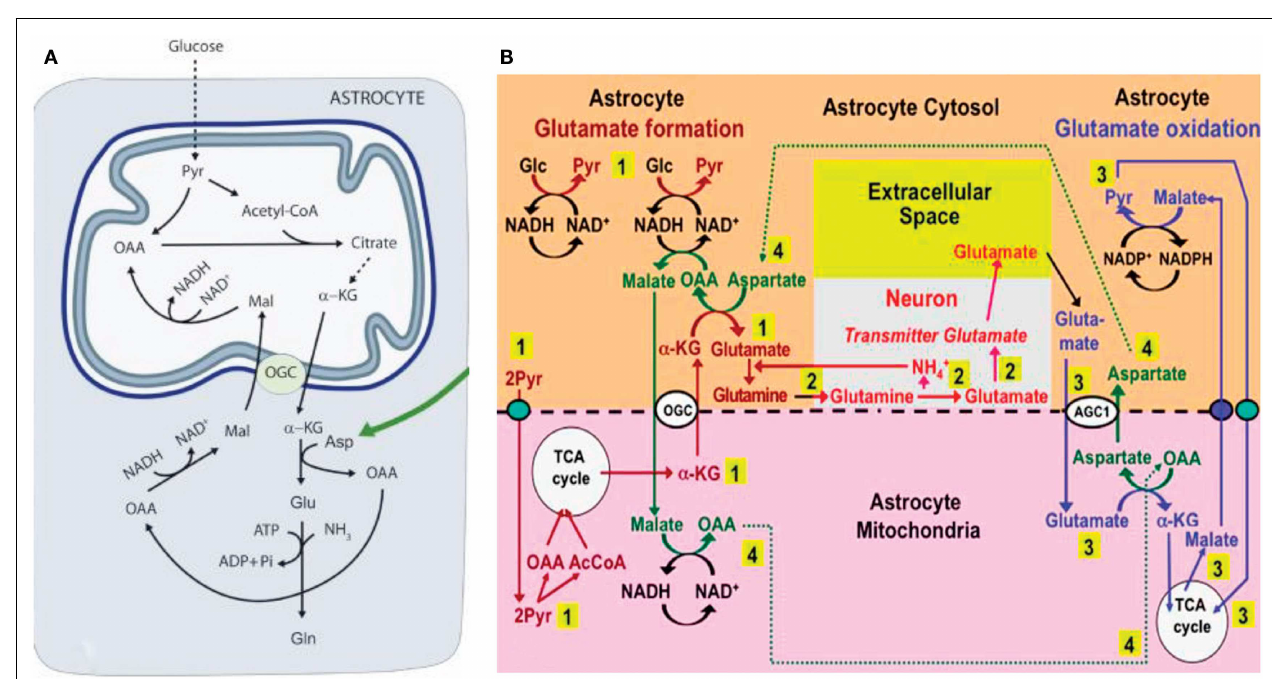
glutamate (pathway 2), and subsequent reuptake of glutamate and oxidative metabolism in astrocytes (pathway 3), with connections between pathways 1 and 3 shown as pathway 4. Biosynthesis of glutamine is shown in brown and metabolic degradation of glutamate in blue. Redox shuttling and astrocytic release of glutamine and uptake of glutamate are shown in black, and neuronal uptake of glutamine, hydrolysis to glutamate, and its release is shown in red. Reactions involving or resulting from transamination between aspartate and oxaloacetate (OAA) are shown in green. Small blue oval is pyruvate carrier into mitochondria and small purple oval malate carrier out from mitochondria. AGC1, aspartate/glutamate exchanger, aralar; α -KG, α -ketoglutarate; Glc, glucose; Pyr, pyruvate; OGC, malate/ α -ketoglutarate exchanger. It should be noted that (i) aralar activity is required initially for reversal of cytosolic NAD + /NADH changes occurring during the one oxidative process occurring during pyruvate formation, but subsequently not in astrocytes until the oxidation of glutamate, probably allowing rapid glutamate synthesis, and (ii) all reactions are stoichiometrically accounted for (A ) From Pardo et al. (2011); (B) From Hertz